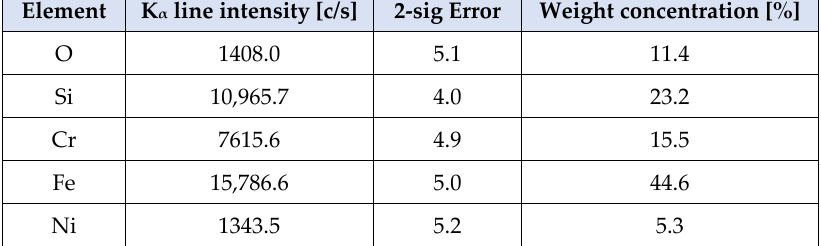
Figure 15. The energy spectrum and microanalysis results of the observed oxides’ chemical composition at the breakthrough from three-point bending of a sinter made of AISI 316L austenitic stainless steel with 0.3 wt% graphite nanopowder with a BET specific surface area of 400 m 2 /g.